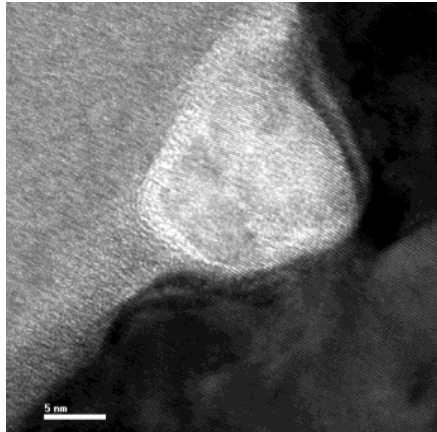
Figure 12. TEM images of a single black spot.